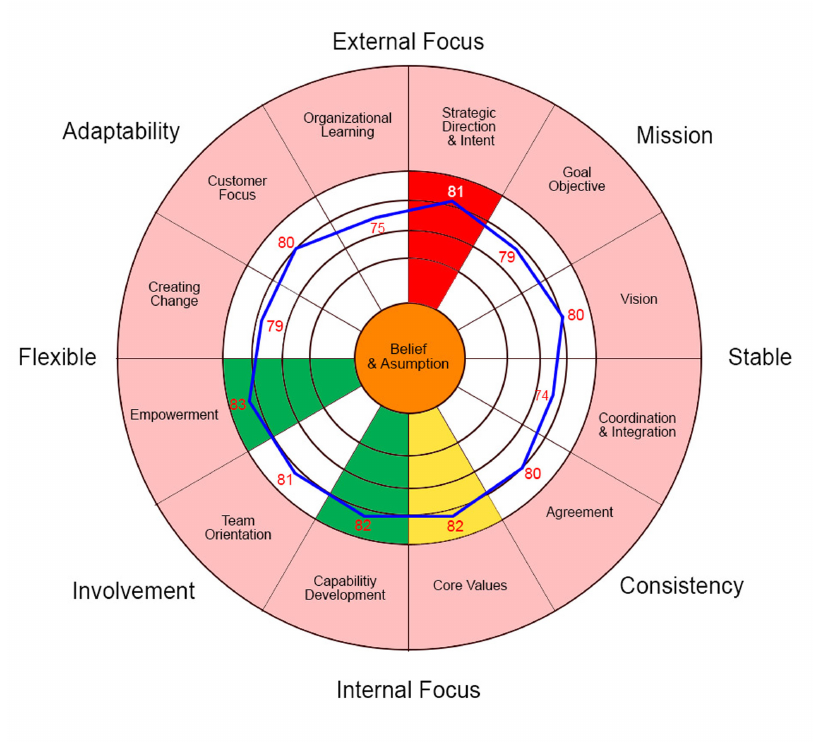
Figure 4. Description of organizational culture in international chain hotel